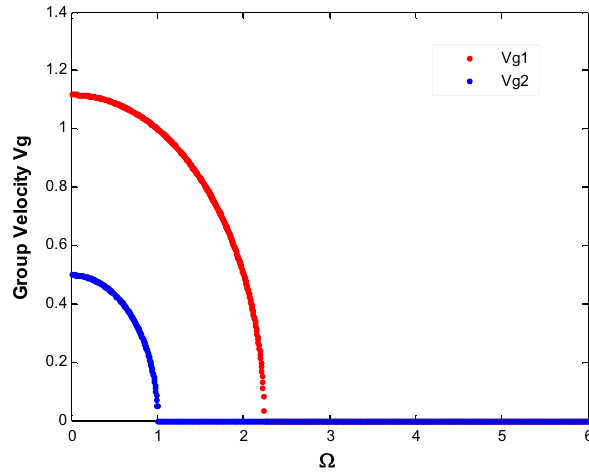
Figure 4: Group velocity mode 1 and mode 2 as function r 2 and dimensionless frequencies Ω